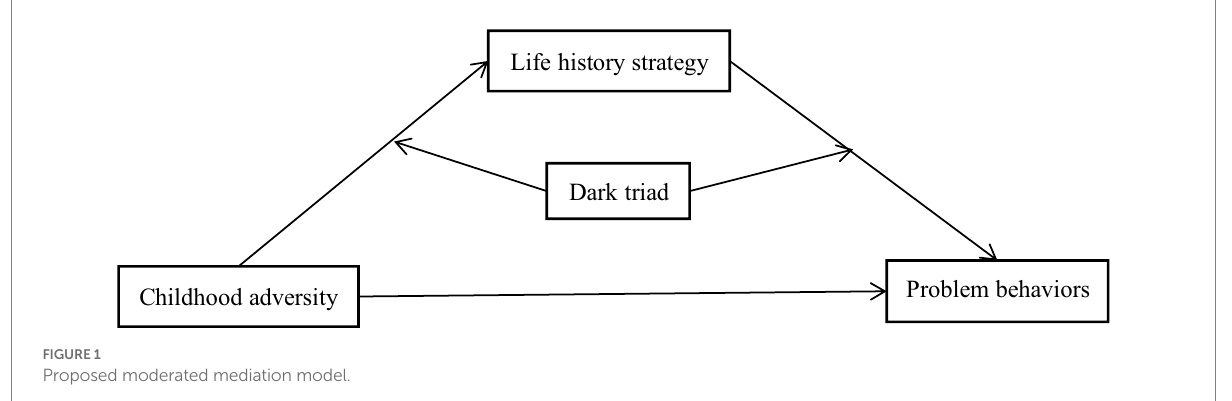
FIGURE 1 Proposed moderated mediation